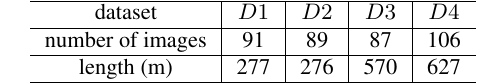
Table 1. The number of images and the length of path for each dataset.